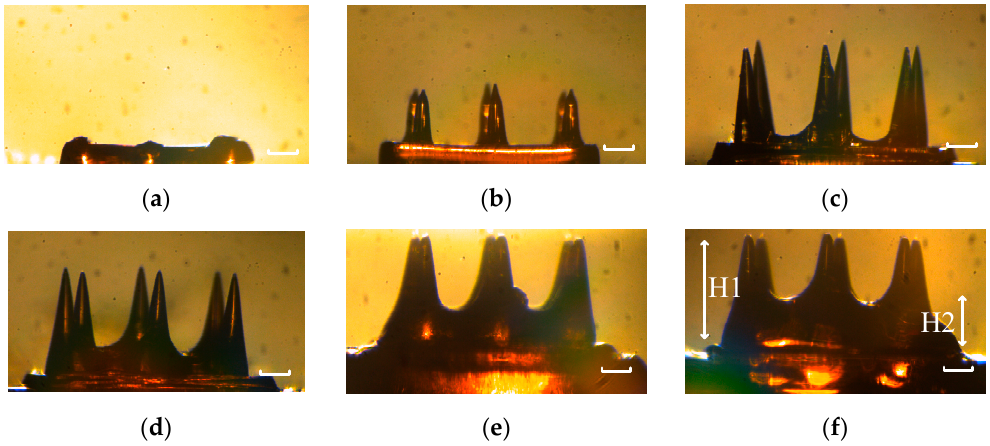
Figure 4. The picture of side face of MNs with different exposure time: ( a ) 50 ms; ( b ) 100 ms; ( c ) 300 ms; ( d ) 500 ms; ( e ) 700 ms; and ( f ) 900 ms. The scale bar is 200 µ m.